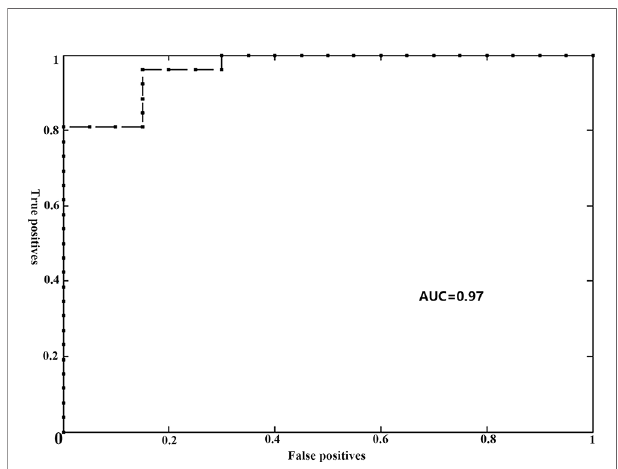
FIGURE 2 | Receiver operator curve (ROC) for individual prediction of RE at the pre-symptomatic stage in patients with NPC. RE, radiation encephalopathy; NPC, nasopharyngeal carcinoma; AUC, the area under the